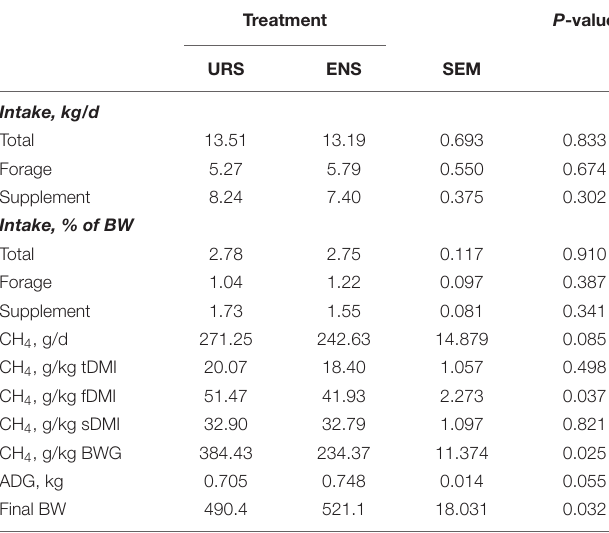
TABLE 1 | Intake, methane emissions and weight gain in grazing Nellore Steers a after 13 months of supplementation with encapsulated nitrate (ENS) or Urea (URS).